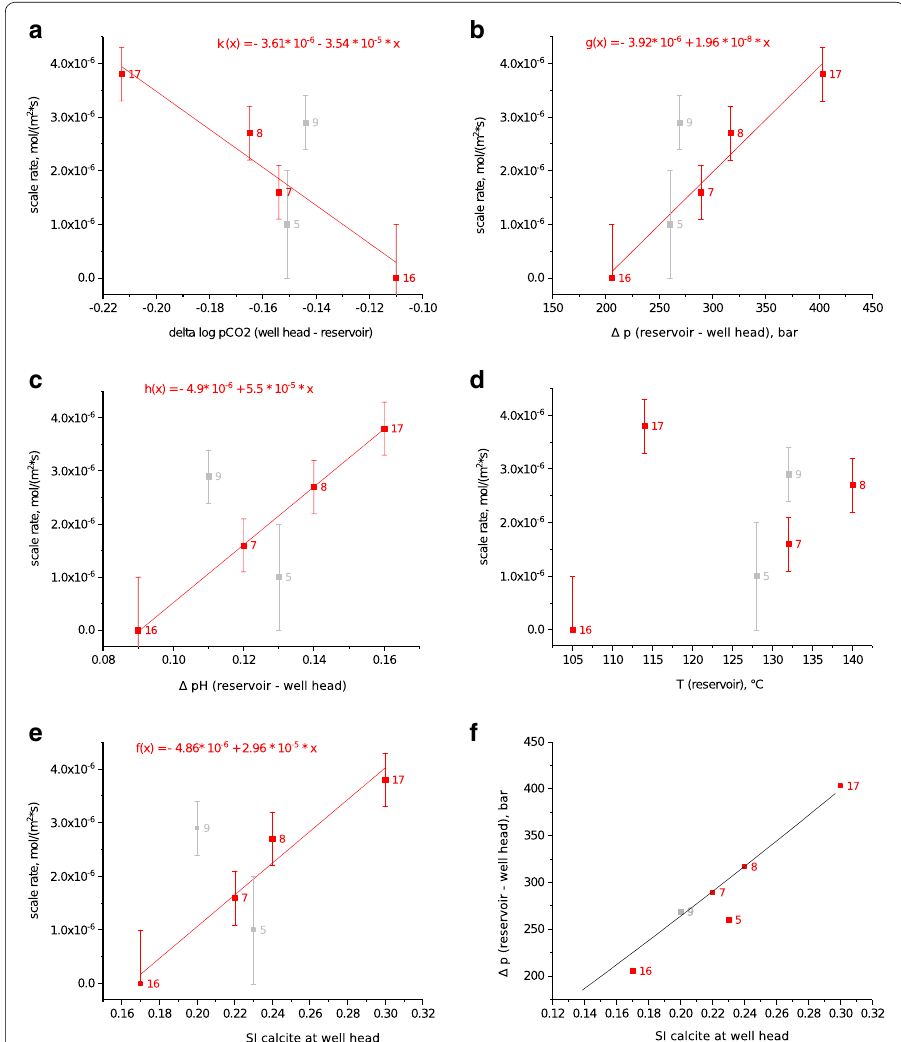
Fig. 4 Correlations between scale rate at the wellhead of the production pipe and different parameters with indication of error bars. Data points labeled with site number. Red data points: reliable data. Grey data points: less reliable or particular data (site 9: many different pumps, site 5: scale thickness according to facility operator). a Scale rate against (cid:31) log (pCO2) between reservoir and wellhead. b ) Scale rate against (cid:31) between reservoir pressure and wellhead pressure. c ) Scale rate against (cid:31) pH between reservoir and wellhead. d ) Scale rate against reservoir temperature. e ) Scale rate against SI calcite at the wellhead. f ) (cid:31) between reservoir pressure and wellhead pressure against wellhead SI calcite . The black line shows the theoretical pressure dependence of SI calcite as calculated with PHREEQC. Linear regressions k(x), f(x), g(x), and h(x) between parameters and scale